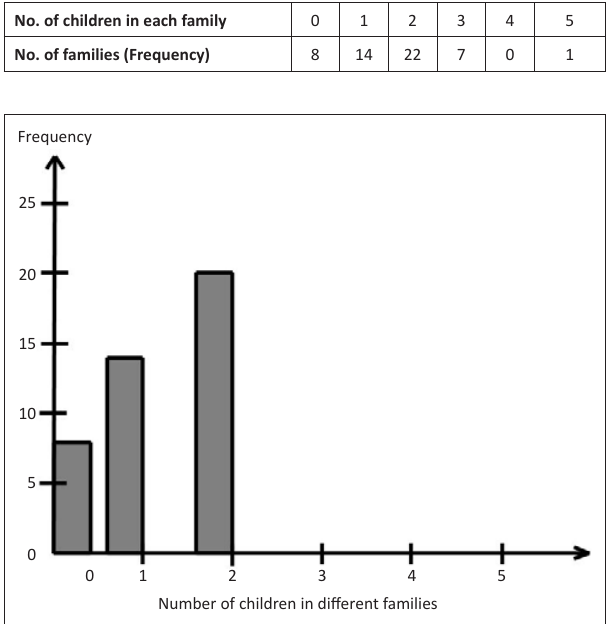
FIGURE 2: Learner’s drawing of bar graph of survey